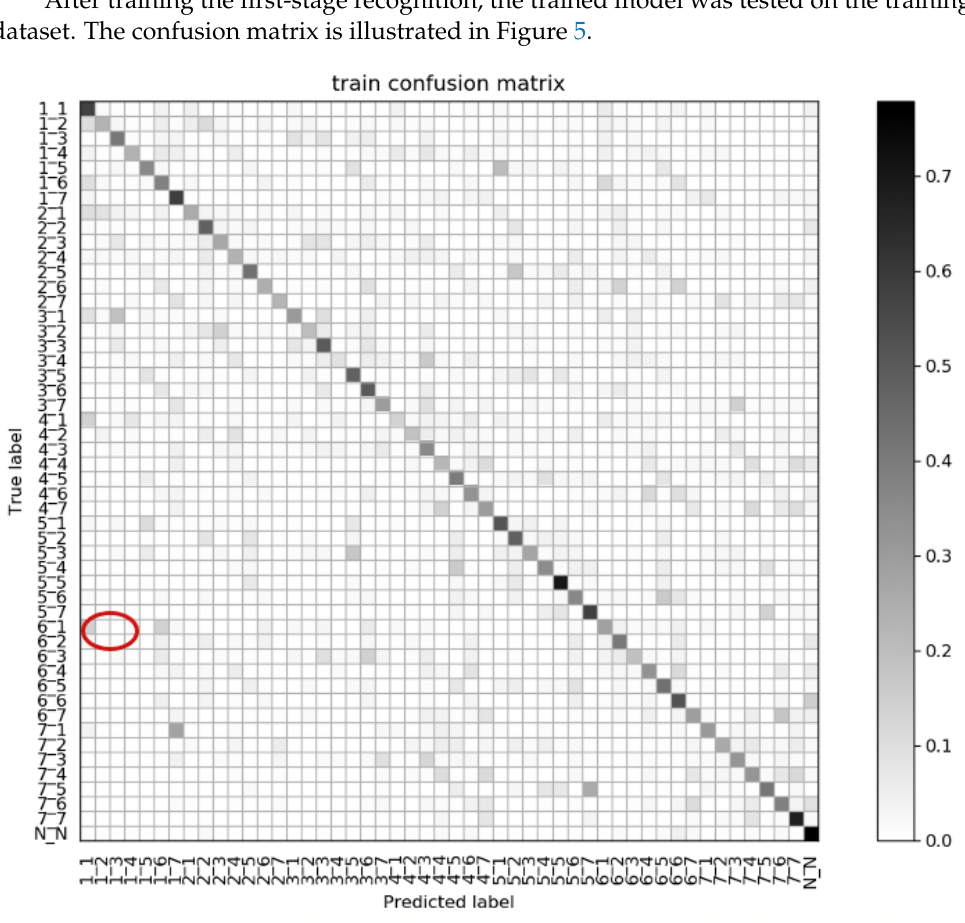
Figure 5. Confusion matrix of the training